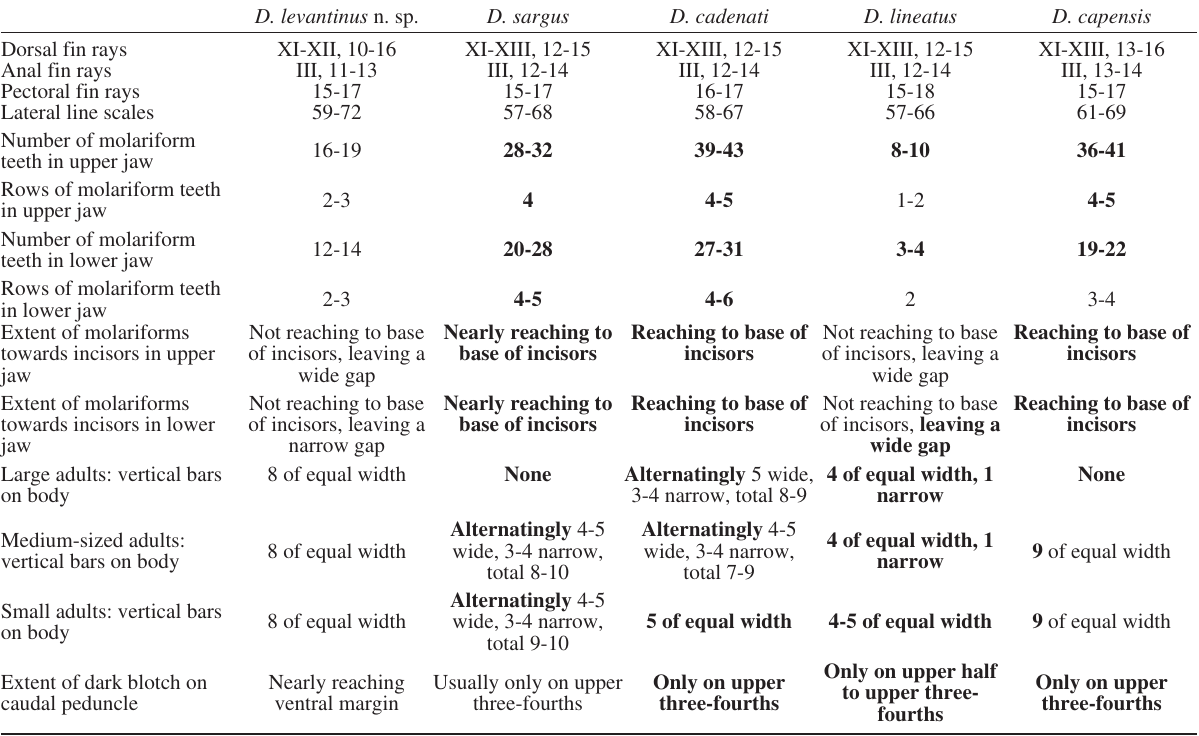
Table 2. – Comparison of eastern Atlantic and Mediterranean species of the Diplodus sargus species